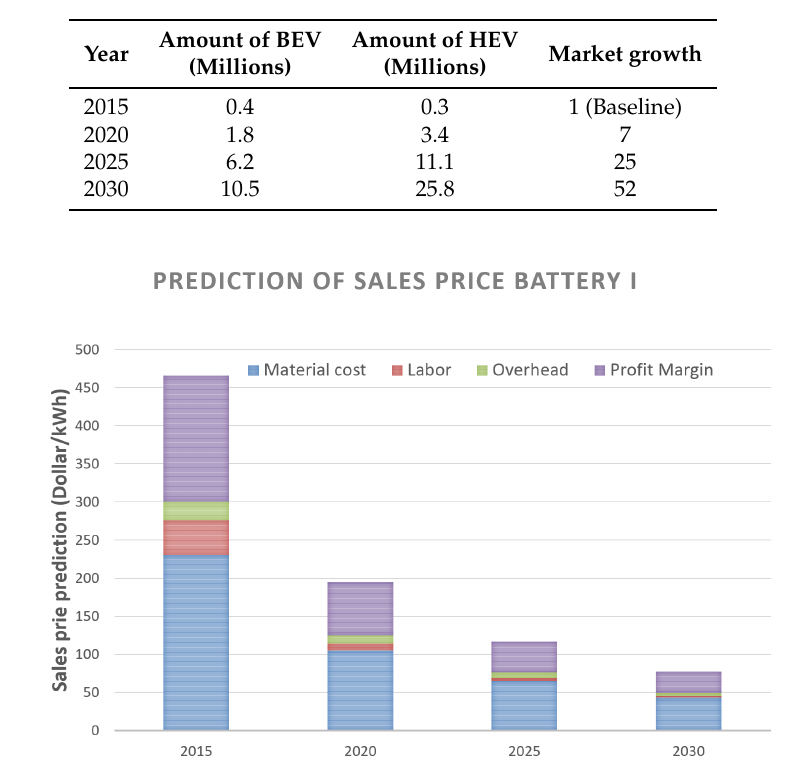
Figure 11. Prediction of sales price of battery I up to 2030.